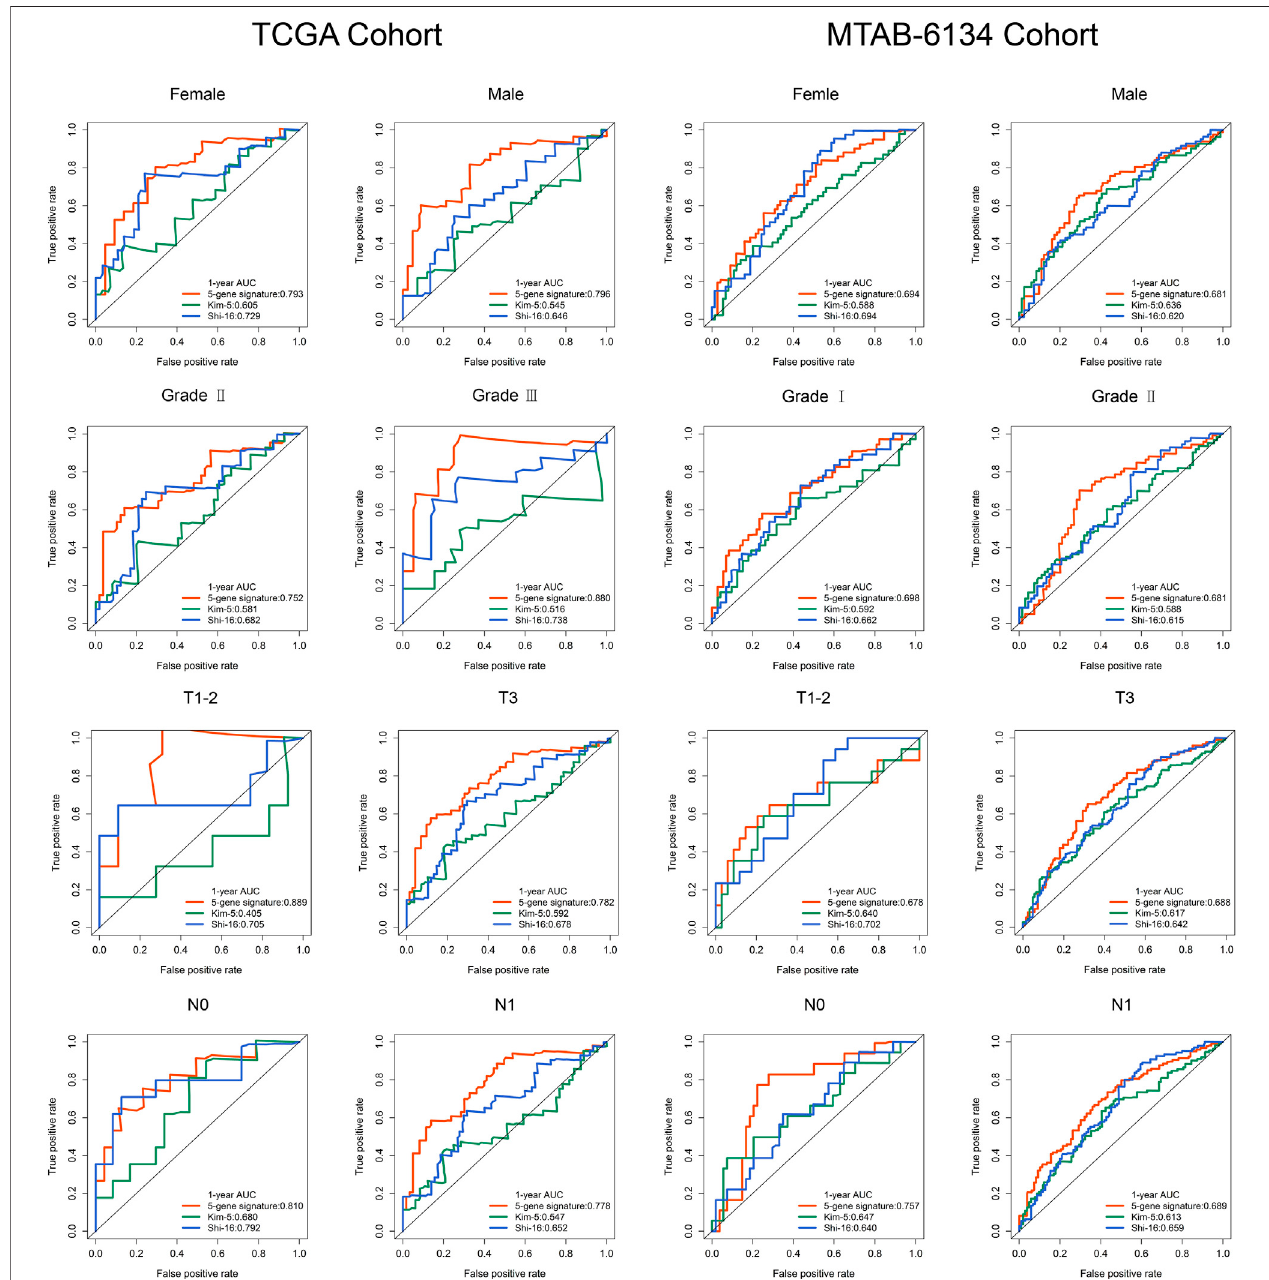
FIGURE 4 | Subgroup analyses evaluate the prognostic stability in TCGA and MTAB-6134 cohorts.